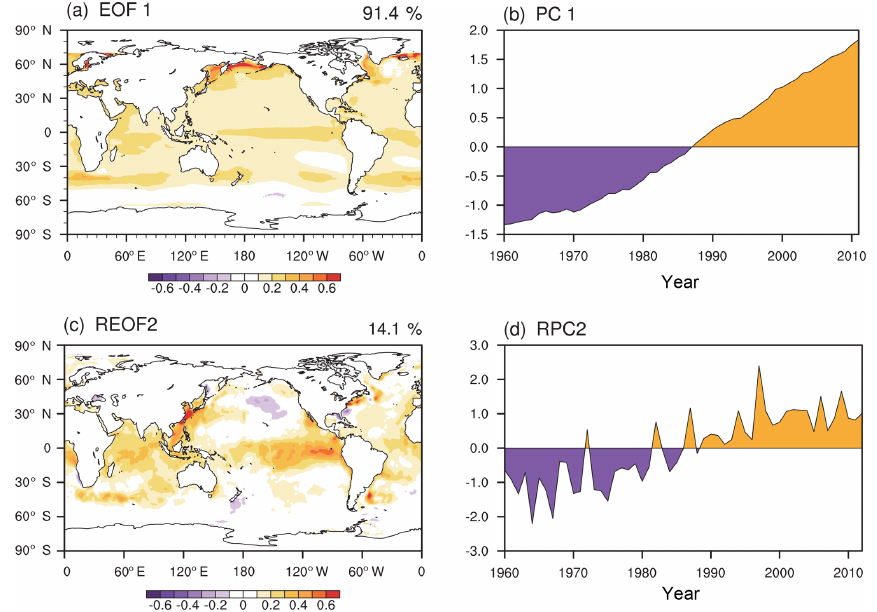
Figure 6. The first leading mode (EOF1; a ) and associated principal component (PC1; b ) of the difference of the winter-mean sea surface temperature forcing between the All-Hist runs and Nat-Hist runs by empirical orthogonal function analysis based on the period of 1960– 2013. The second leading mode (REOF2; c ) and associated principal component (RCP2; d ) of the winter-mean sea surface temperature from the HadISST data by rotated empirical orthogonal function analysis based on the period of